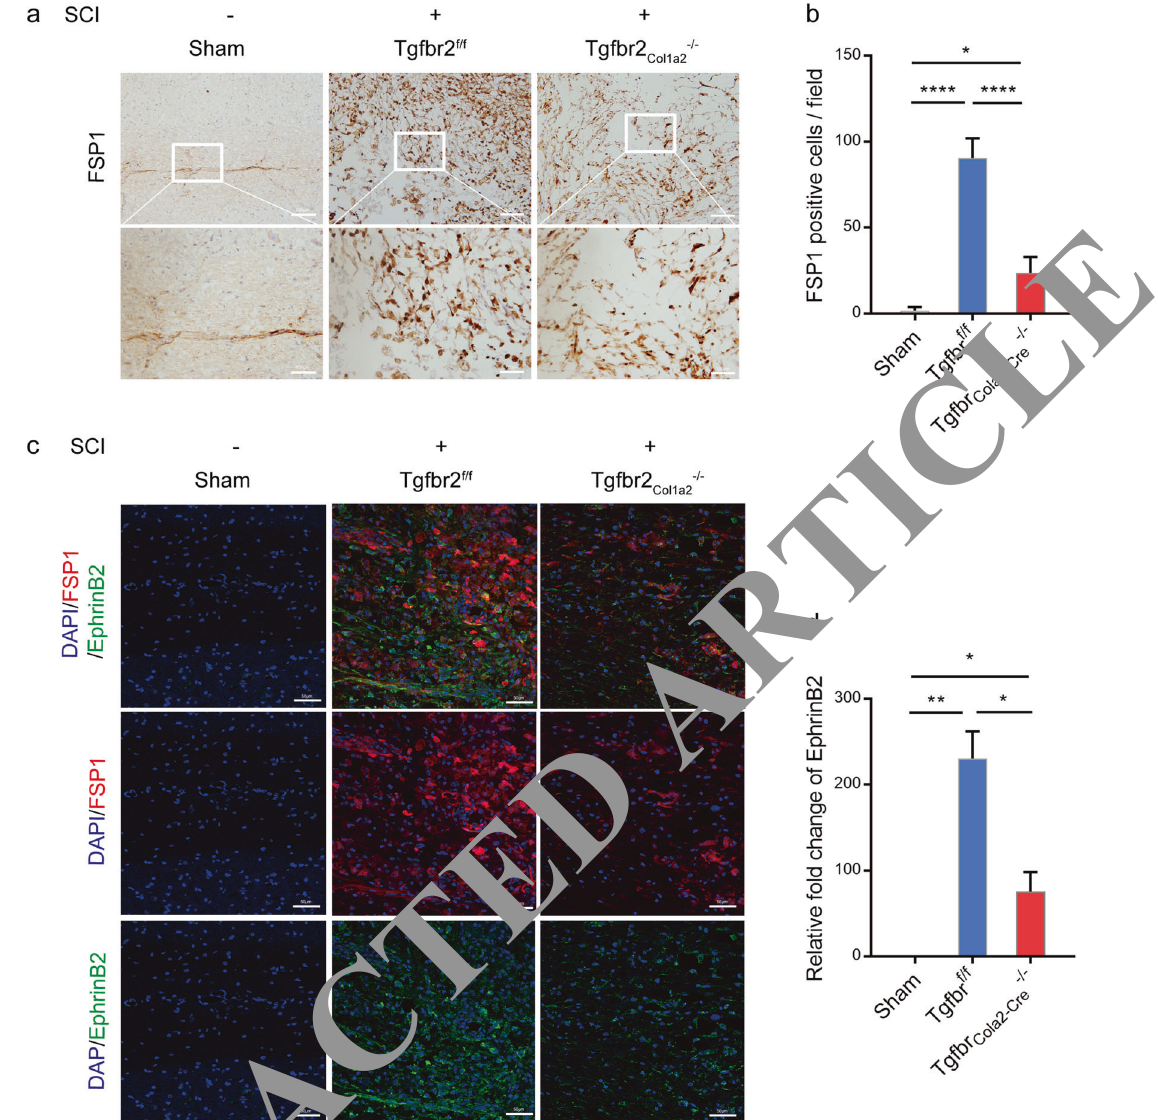
Fig. 3 Genetic knockout TGF- β receptor 2 in fi broblasts attenuates EphrinB2 expression and induced nerve distribution. a Representative images of Immunohistochemistry analysis of FSP1 in Tgfbr2 Col1 α 2 − / − mice and Tgfbr2 fl ox/ fl ox mice after SCI and Tgfbr2 fl ox/ fl ox mice without surgery (Sham) at 2 weeks. Scale bars = 100 μ m. Images on the bottom are high-resolution versions of the boxed regions in the top images, scale bars = 25 µm. b , c Quantitative analysis of FSP1 positive cells/ fi eld (* p < 0.05, **** p < 0.0001, n = 4). c Representative images of immuno fl uorescence analysis of FSP1 (red), EphrinB2 (green) and DAPI (blue) in each group at 2 weeks after SCI. Scale bars = 50 μ m. d Quantitative analysis of relative fold change of EphrinB2 (* p < 0.05, ** p < 0.01, n =